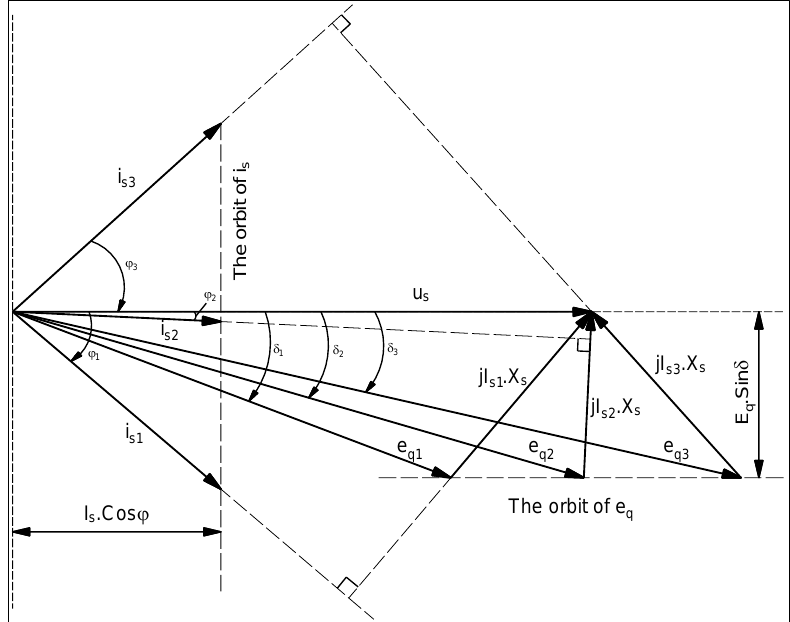
Figure 10. The influence of the excitation source on the working